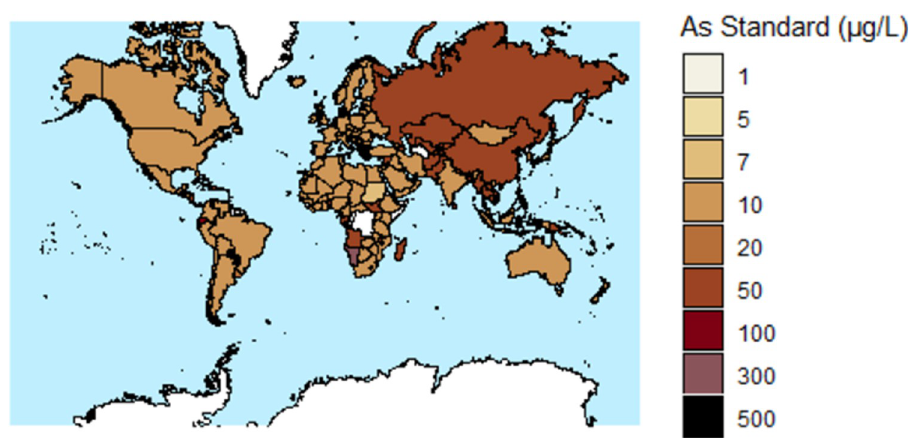
Fig 5. A map of national drinking water standards or guidelines for arsenic in micrograms per liter ( μ g/L) for 180 countries (map base: [264]).